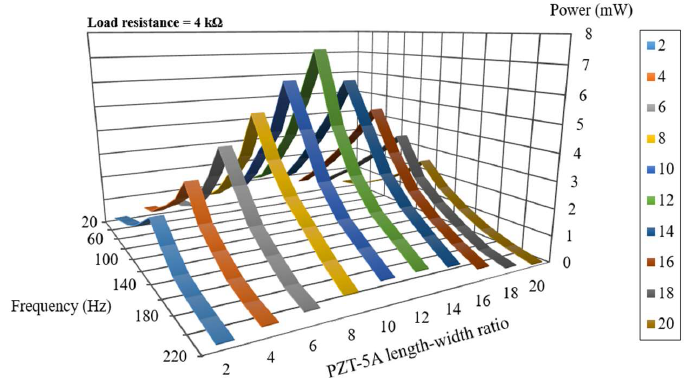
Figure 2. Output power at varying load resistances.